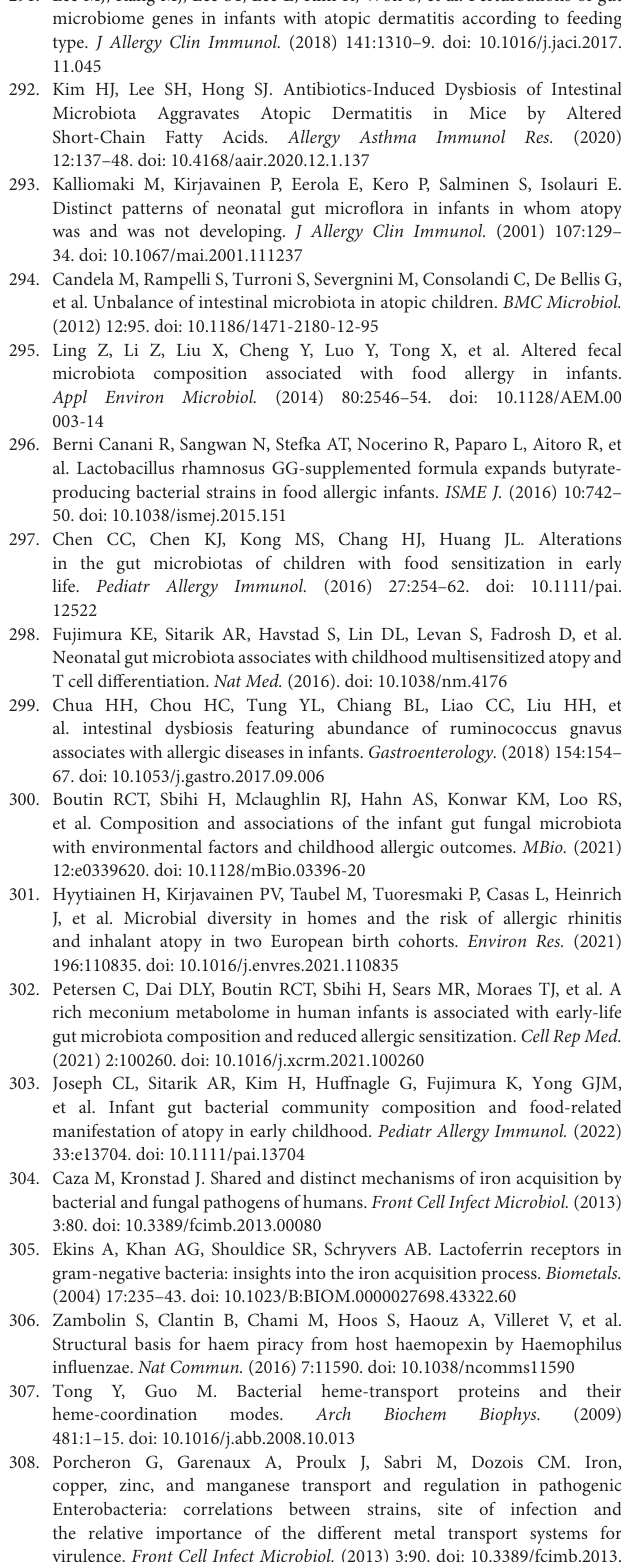
the Table for Microbial Cross-Feeding. Microbiol Mol Biol Rev. (2021) 85. doi: